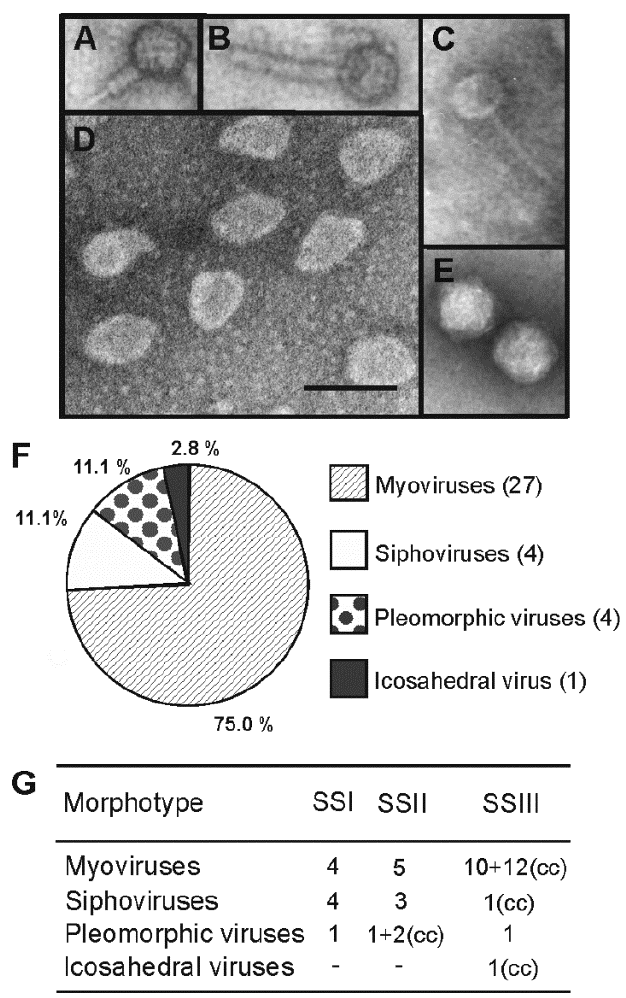
Figure 2. Transmission electron micrographs and morphotype distribution of the virus isolates. ( A – B ) Myovirus morphotype (Isolate No. 4, HRTV-16) with the tail in ( A ) contracted and ( B ) extended conformations; ( C ) Siphovirus morphotype (Isolate No. 28, HCTV-28); ( D ) Pleomorphic virus morphotype (Isolate No. 32, HRPV-6); ( E ) Icosahedral virus morphotype (Isolate No. 36, HCIV-1). Scale bar in D is 100 nm for all panels; ( F ) The percentages of different virus morphotypes isolated from SSII and SIII samples; ( G ) Numbers of viruses isolated from samples SSI [22], SSII, and SSIII on the endogenous strains derived from the same sample and culture collection (cc)